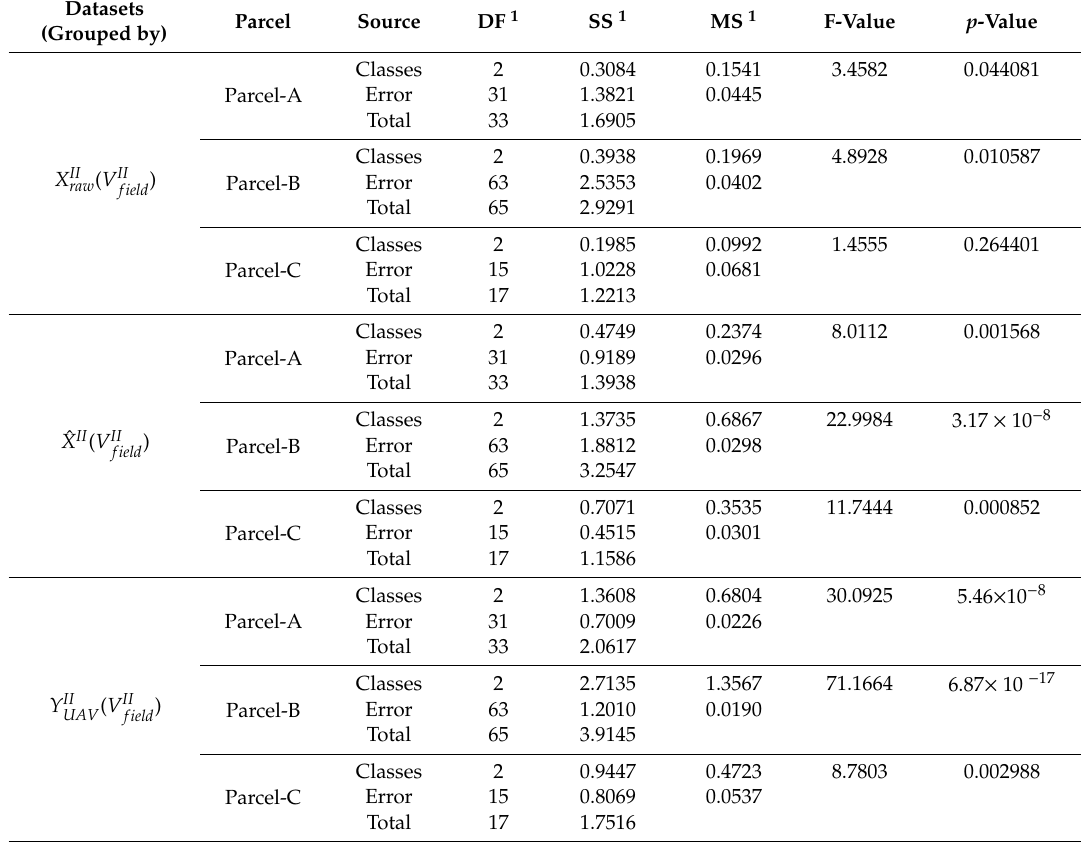
grouped according UAV